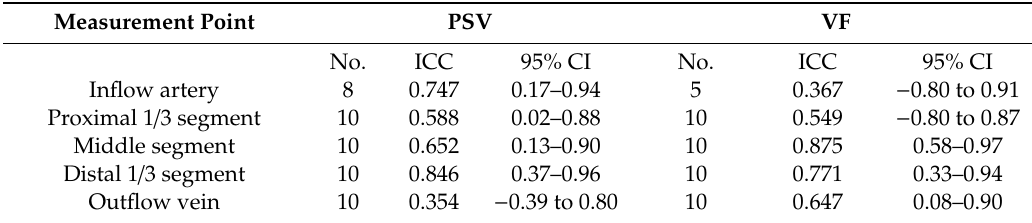
Table 2. Reliability of consecutively measured peak systolic velocity (PSV) and volume flow (VF) values. Measurement Point